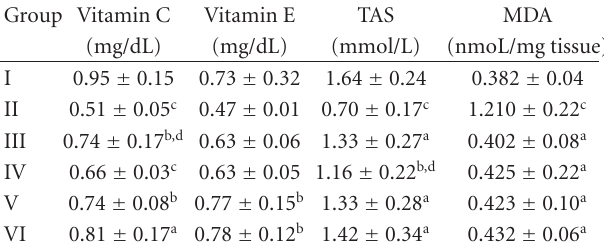
Table 3: E ff ect of antioxidant supplementation on antioxidant indices and lipid